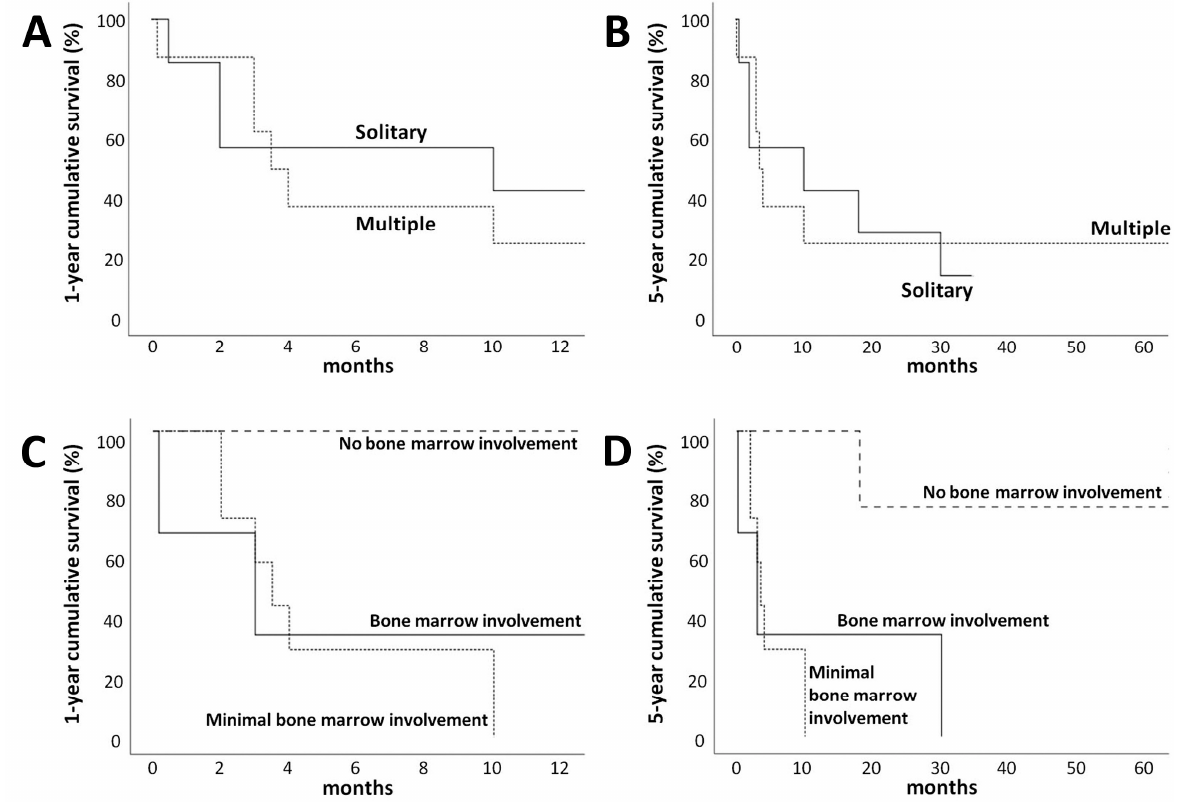
Figure 6. One-year and five-year cumulative survival rates: ( A , B ) comparison of cumulative survival between patients with solitary and multiple skin lesions; ( C , D ) comparison of cumulative survival between patients with bone marrow involvement, minimal bone marrow involvement, and no bone marrow involvement.